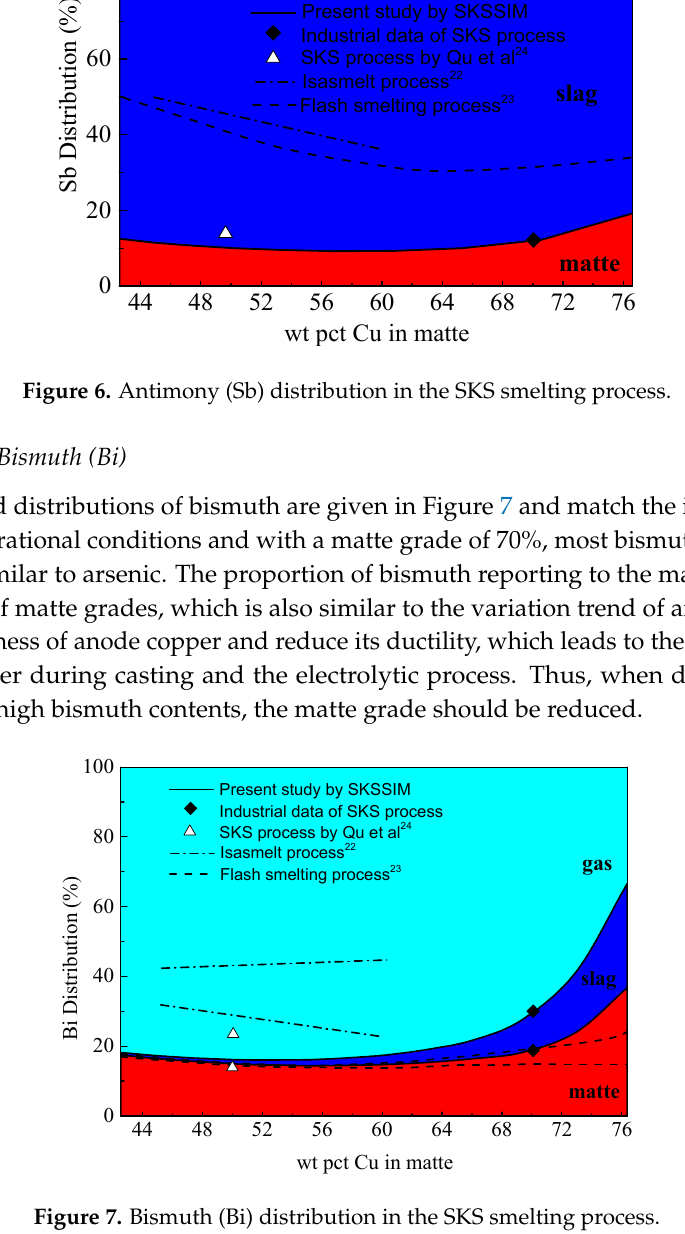
Figure 7. Bismuth (Bi) distribution in the SKS smelting process.